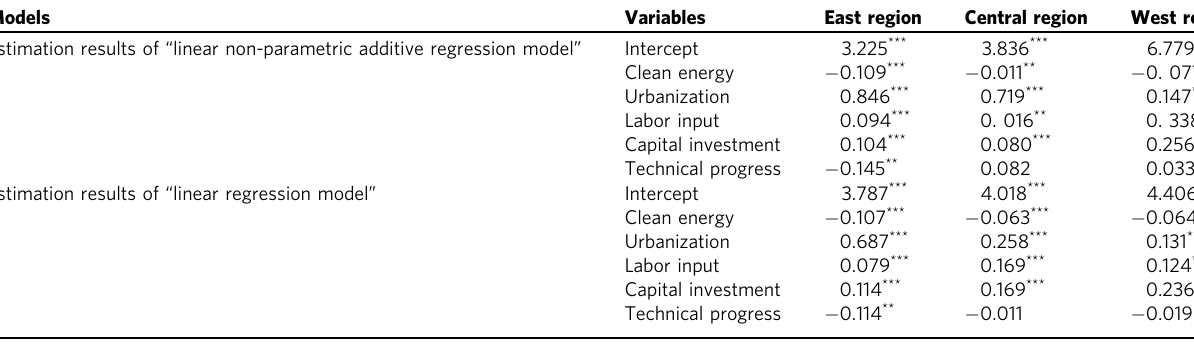
Table 2 Linear effect of CED on regional economic growth. Models Estimation results of “ linear non-parametric additive regression model ”